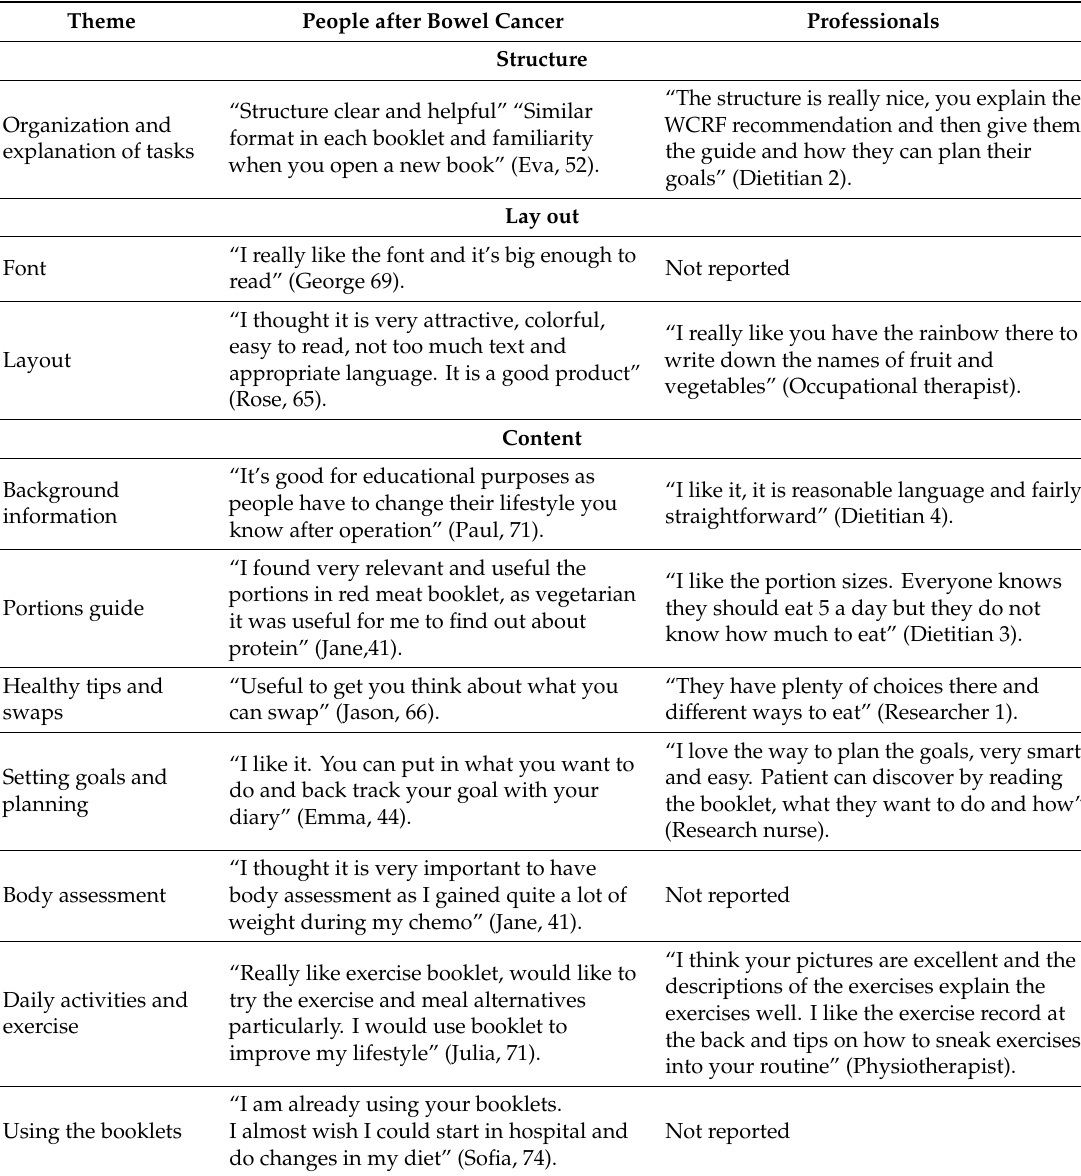
Table 2. Positive feedback from participants on HEAL ABC